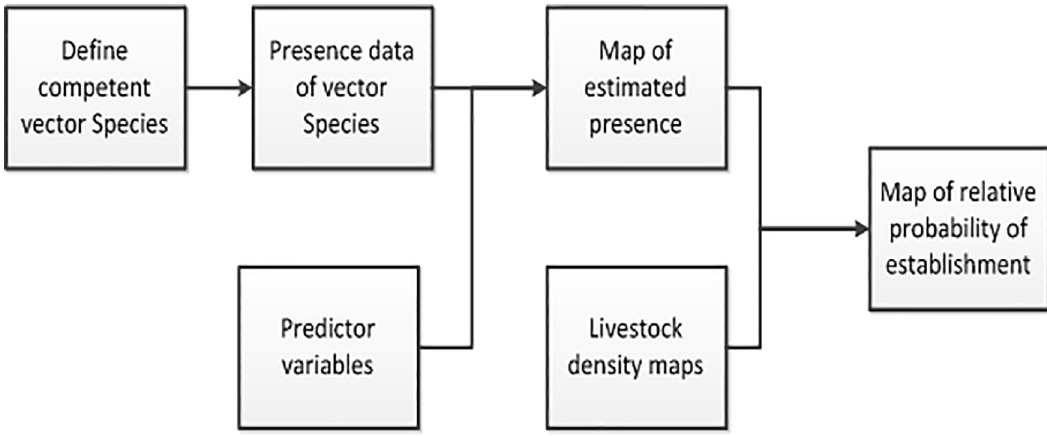
Fig 1. Framework to assess the relative spatial risk of establishment of rift valley fever